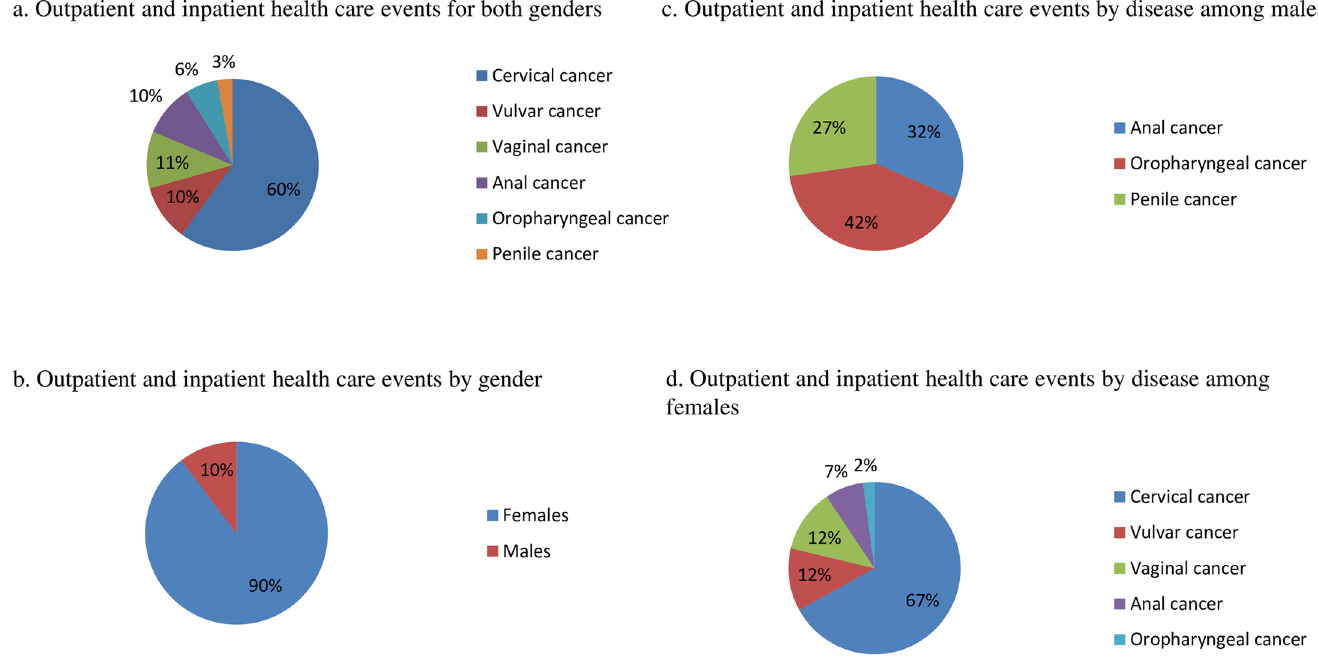
Fig 1. HR HPV-attributable fraction of outpatient and inpatient health care events by high-risk human papillomavirus-related disease and gender. (a) Outpatient and inpatienthealth care events for both genders. (b). Outpatientand inpatienthealth care events by gender. (c). Outpatient and inpatient health care events by diseaseamongmales (d) Outpatient and inpatienthealth care events by diseaseamong females.